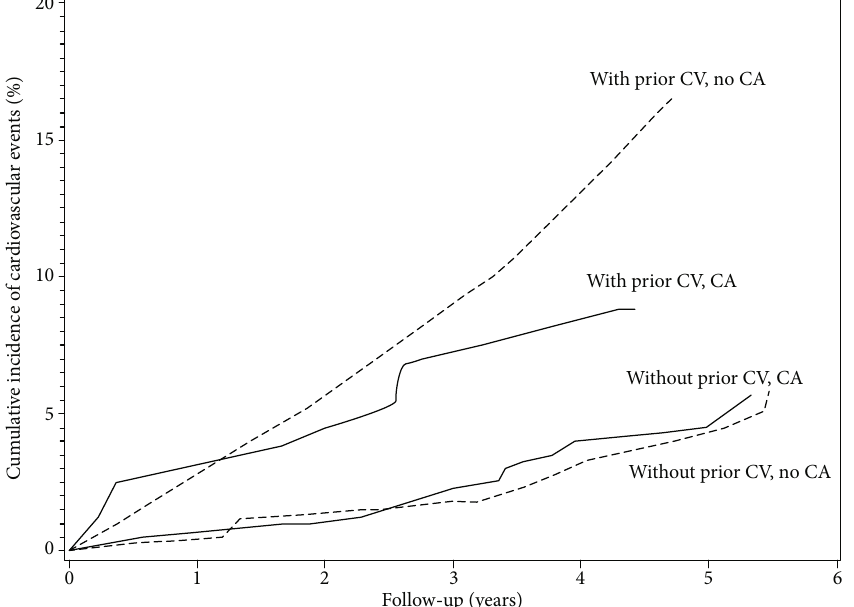
Follow ‑ up Figure 4: Cumulative incidence of new cardiovascular events. CV: cardiovascular event; CA: carotid atherosclerosis. (log-rank test to compare survival curves between all strata, p = 0 : 189